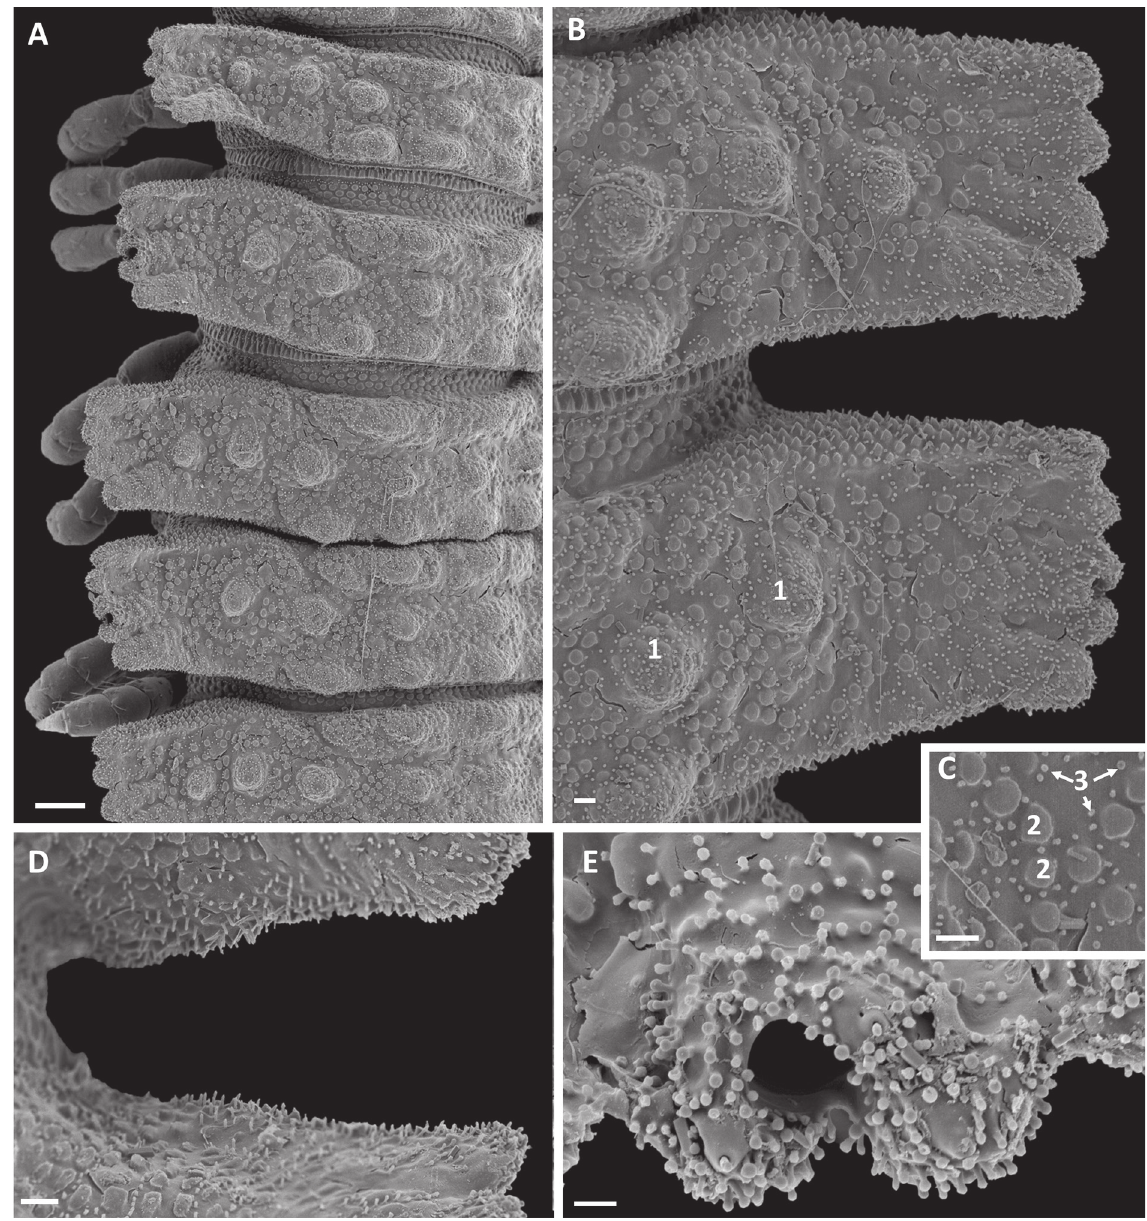
Fig. 3. Cryptocorypha geminiramus sp. nov., paratype (NHMD 621824), ♂, from Kidatu. A . Rings 4–8, (latero)dorsal view. B . Paraterga 8–9, dorsal view. C . Enlarged detail of B, showing level 2 buttons and level 3 spherules. D . Anterior and posterior edge, respectively, of successive paraterga, ventral view. E. Left ozopore on ring 5, oblique lateral view. Abbreviations: 1 = level 1 tubercles; 2 = level 2 buttons; 3 = level 3 spherules. Scale bars: A = 0.05 mm; B–D = 0.01 mm; E = 0.005